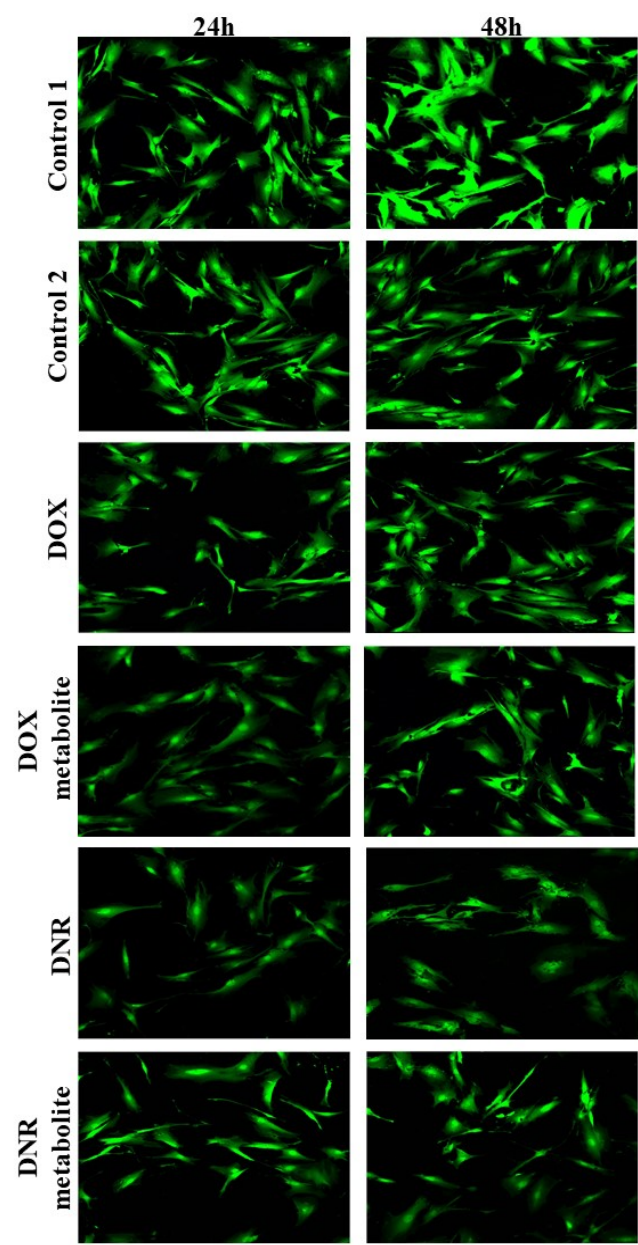
Figure A3. The effect of conditioned media on the calcein AM after 24 h, and 48 h in BJ fibroblasts. Control 1—cell culture medium with PBS, Control 2—cell culture medium with Park Robinson medium for fungi culture, DOX—cell culture medium with doxorubicin, DOX metabolite—cell culture medium with doxorubicin after fungi culture, DNR—cell culture medium with daunomycin, DNR metabolite—cell culture medium with daunomycin after fungi culture. Photomicrographsare shown at 200 × magnification.